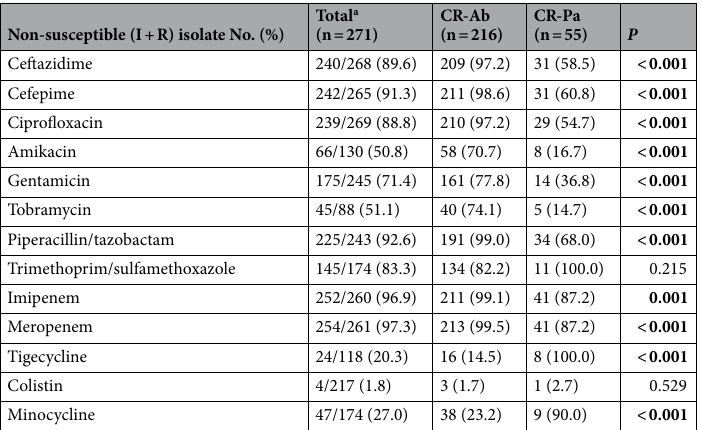
Table 2. Antibiotic susceptibility of carbapenem-resistant Acinetobacter baumannii (CR-Ab) and carbapenem- resistant Pseudomonas aeruginosa (CR-Pa) isolates. I, intermediate; R, resistant; a Not all isolate susceptibility test results were available, and the results are presented as non-susceptible isolate number/available total (%). Significant values are in [bold].